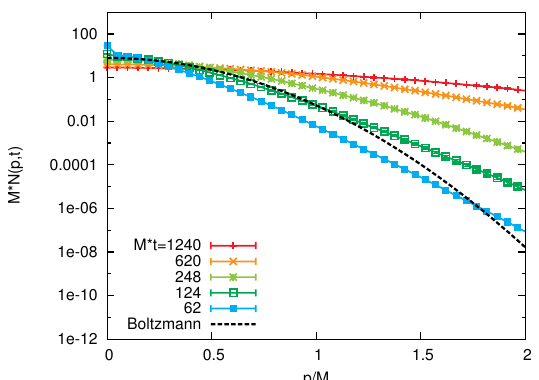
Figure 6 . Time evolution of the momentum distribution of a heavy quark without dissipation. The bars denote statistical errors and the dashed line corresponds to a Boltzmann distribution with T = 0 : 1 M